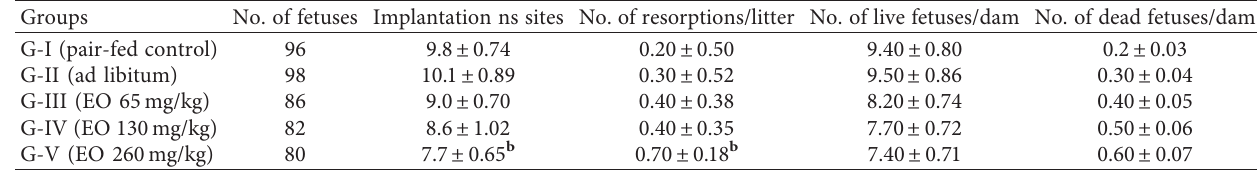
Table 5: Pregnancy outcomes of the day 20 experiment after administration of Thymus schimperi essential oil. Groups